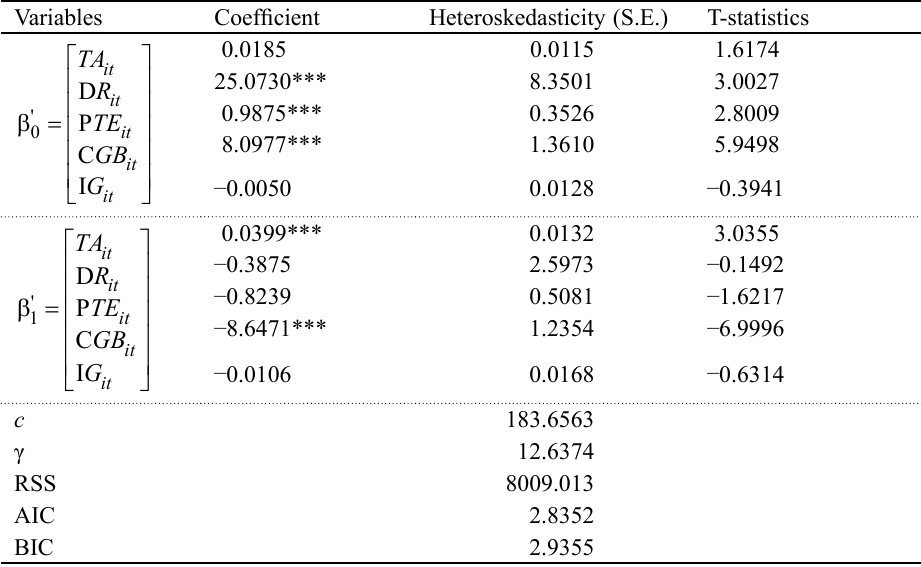
Table 4. Estimation results of the one-threshold PSTR model for large-sized banks Variables